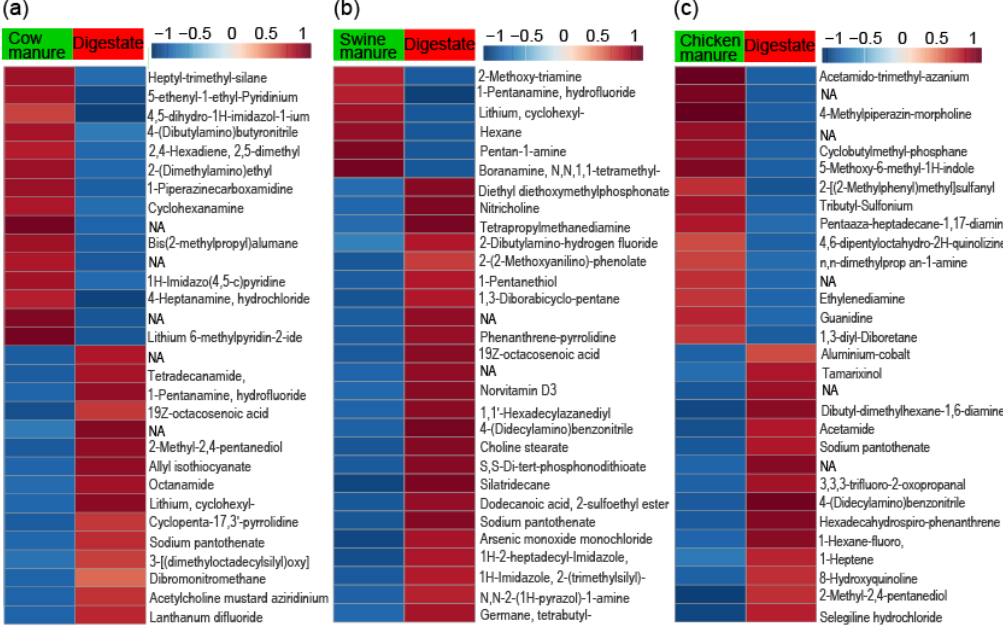
Figure 3. Interactive, sortable heat map with customized metabolomic data; ( a ) cow manure and digestate, ( b ) swine manure and digestate, ( c ) chicken manure and digestate ( p < 0.05).